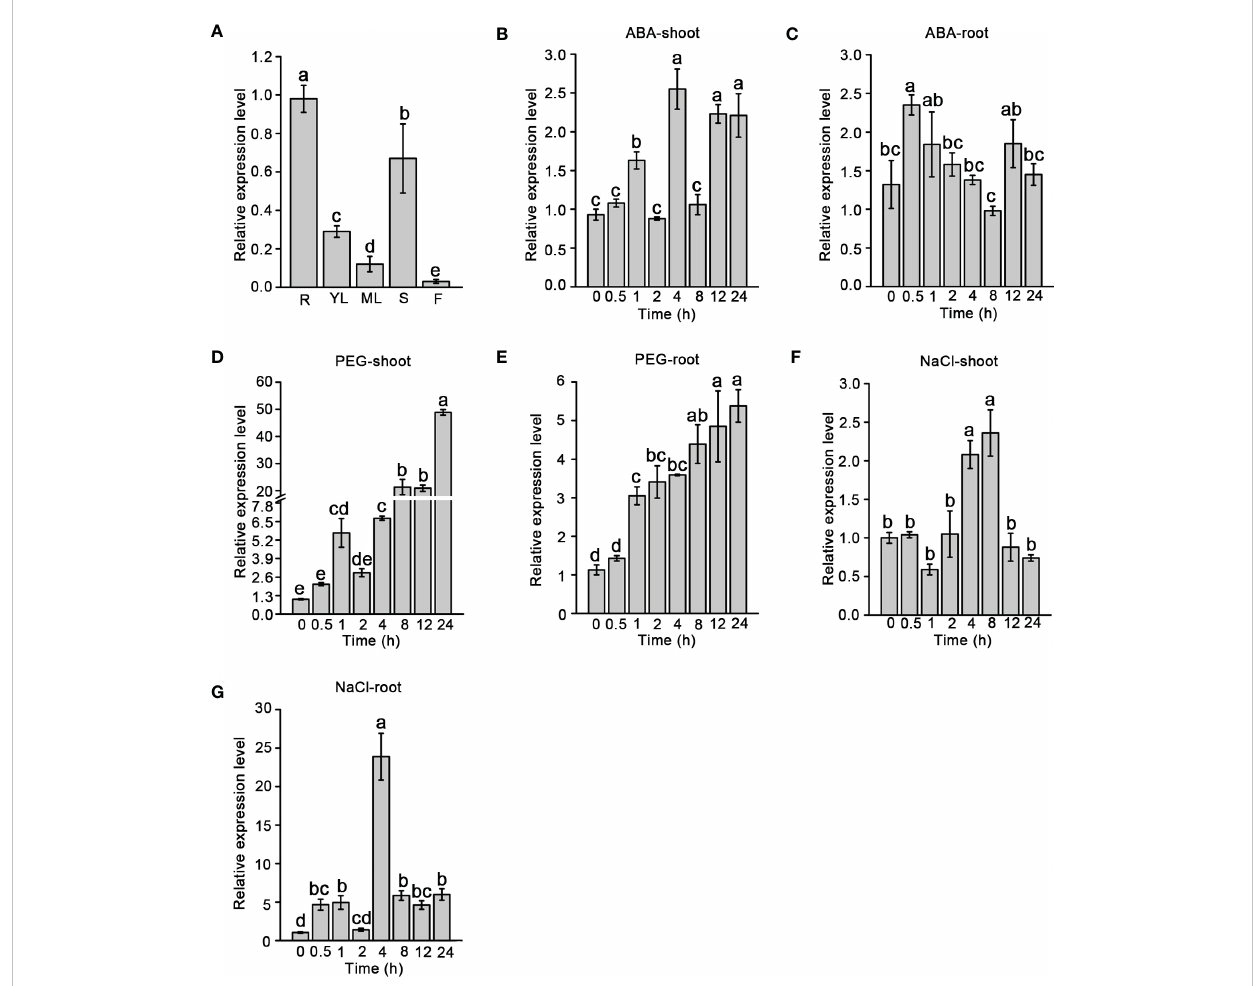
FIGURE 3 SiNCED1 gene expression pattern. (A) SiNCED1 gene expression in different organs. R(root), YL(young leaf), ML(mature leaf), S(stem), F( fl ower). (B – G) The three-leaf stage seedlings were submitted to ABA and 20% PEG, 150 mM NaCl treatment. (B, C) Expression of SiNCED1 under ABA treatment; (D, E) Expression of SiNCED1 under 20% PEG stress; (F, G) Expression of SiNCED1 under 150 mM NaCl stress. The shoot and root samples were collected for SiNCED1 expression analysis. Data are the mean ± SD for three replicates. Different letters represent signi fi cant differences at P <0.05 (ANOVA analysis, Tukey ’ s multiple comparisons test )